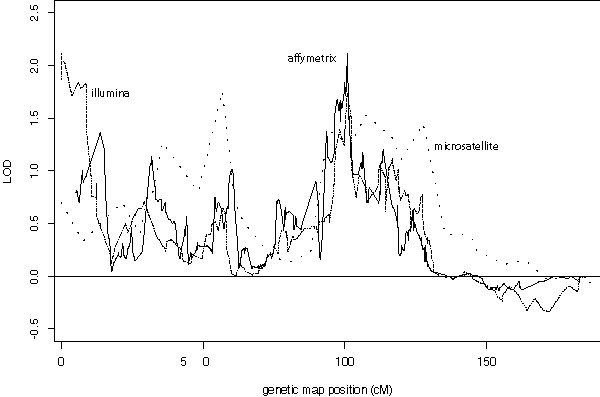
K-C LOD scores for NPLall for three datasets on chromosome 7. Three linkage analysis results are included: microsatellite multipoint, one run for Illumina data (1 Mb-to-1 cM rule), and one run for Affymetrix data (1 Mb-to-1 cM rule).